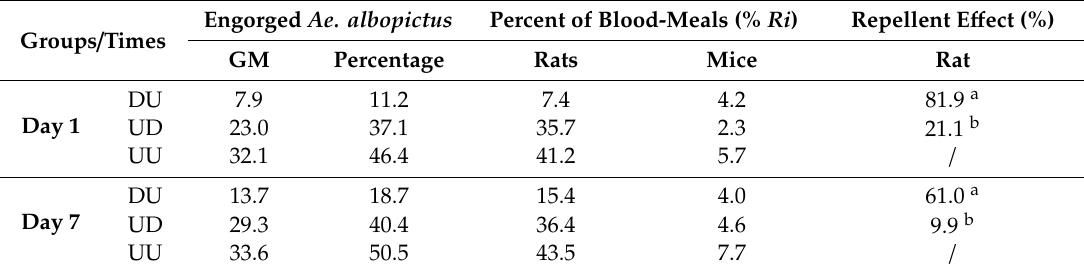
Table 4. Results of the engorgement rates on rodents (rats and mice) and the direct and indirect repellent e ff ect of Vectra ® 3D against Ae. albopictus in the presence of both treated and untreated hosts respectively, at a distance of 30 cm between